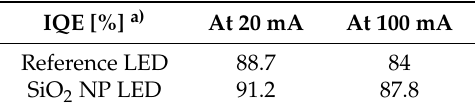
Table 1. Internal quantum efficiency (IQE) of the SiO 2 nano-particle (NP) light emitting diode (LED) and the reference LED (Experimental result).